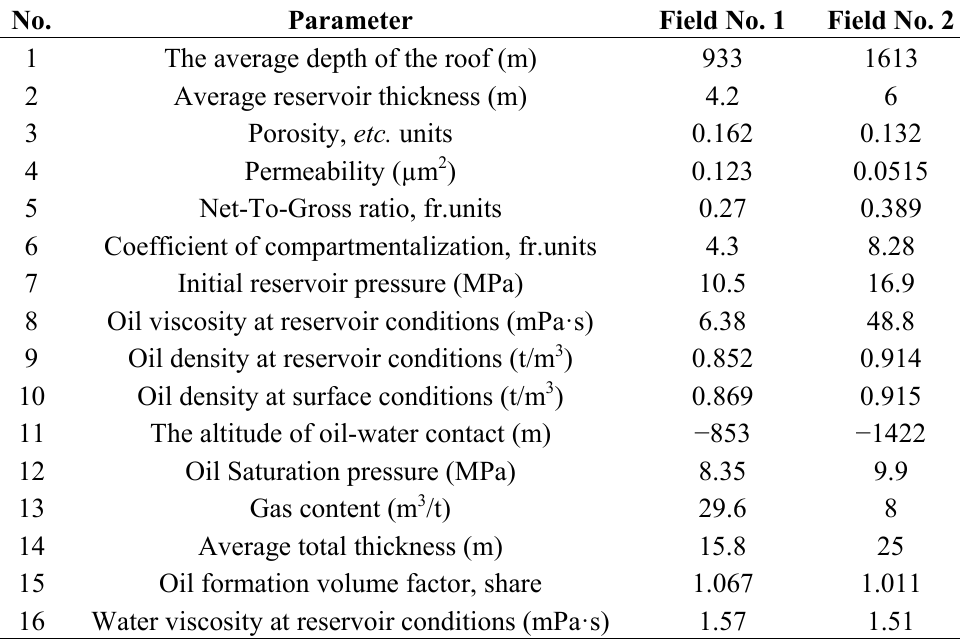
Figure 3. Geological map of selected fields. UKD—The Upper-Kama depression; PA—Perm anticline; BA—Bashkir anticline; 1—Kliegopskaya shaft shaped zone; 2—Nozhovskiy protrusion; 3—Kuedinskiy shaft; 4—Moskudinskiy shaft; 5—Dubovogorskaya terrace. Table 4. Geological and physical characteristics of selected